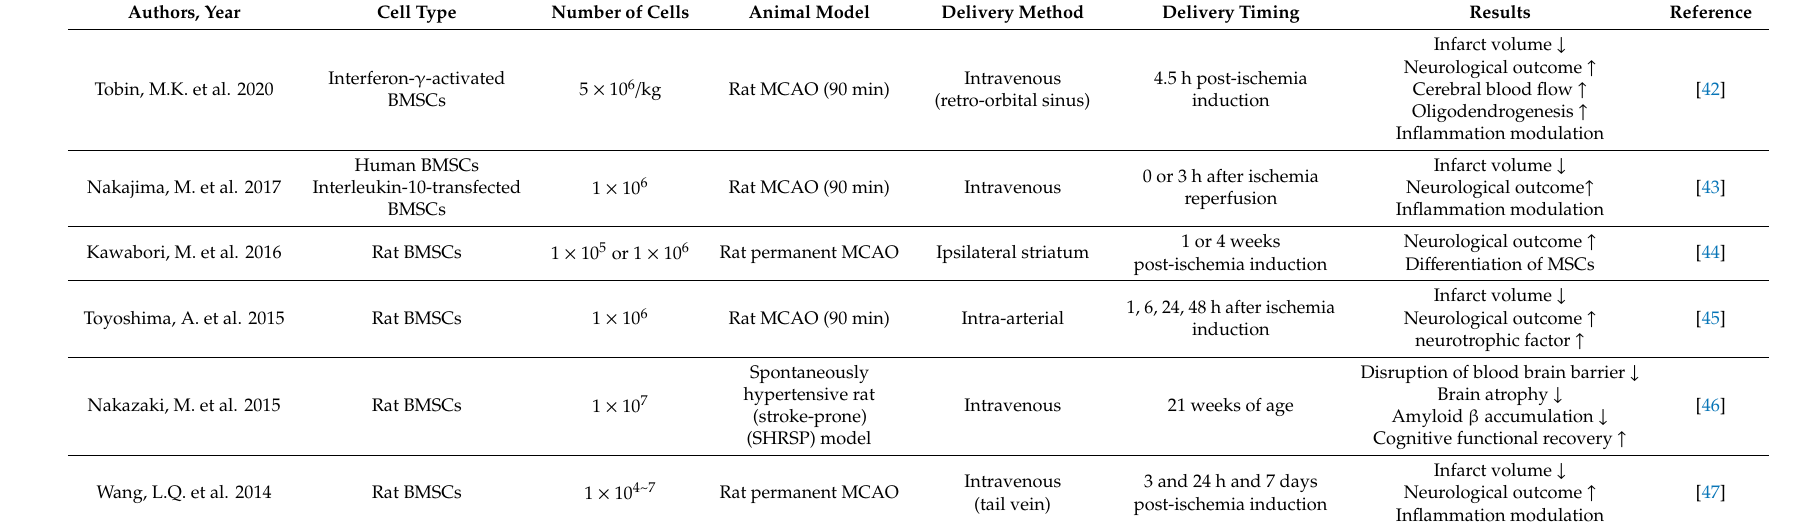
Table 2. Experimental study for the bone marrow mesenchymal stem cell (BMSCs) transplantation into ischemic brain injury in animal